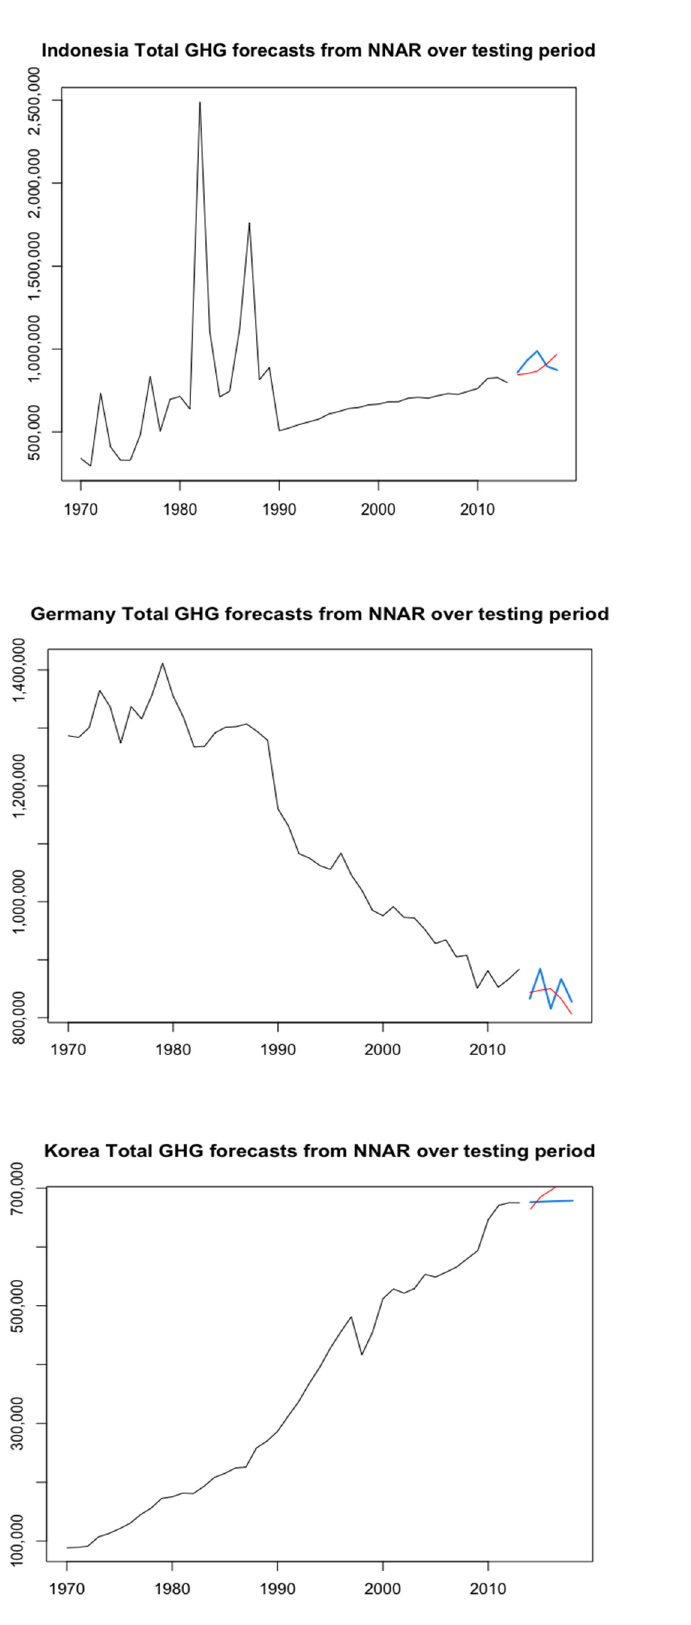
Figure A1. Countries (Predicted Line in Blue versus Real Time Evolution in Red).